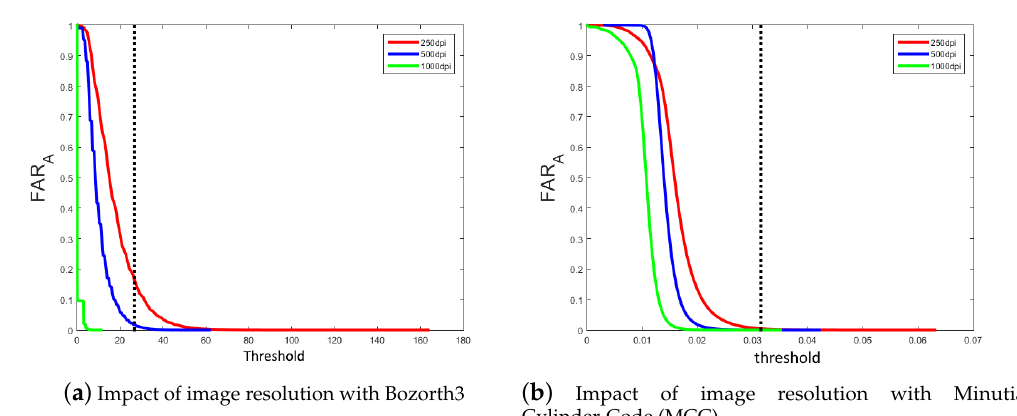
Figure 5. Evolution of the effectiveness of attacks by considering the three resolutions of the sensor for the two matching algorithms. The dot line corresponds to the threshold value associated to the Equal Error Rate (EER) performance (see Section 2.1.2).